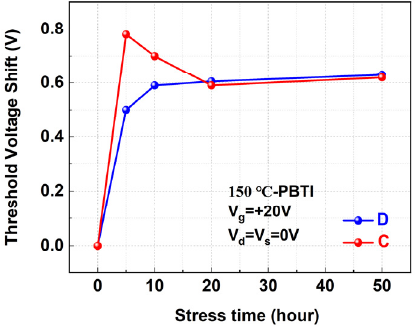
Figure 6. Threshold voltage shifts for ( a ) positive bias-stress of +20 V; ( b ) negative bias-stress of − 10 V for 50 h for commercial SiC MOSFETs. The error bars represent the spread of 5 devices measured for each vendor.